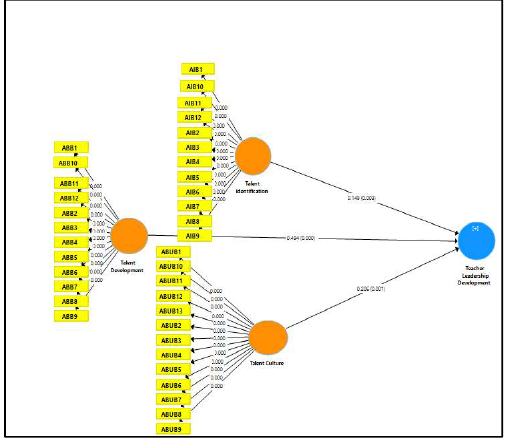
Fig. 3. Structural model assessment result